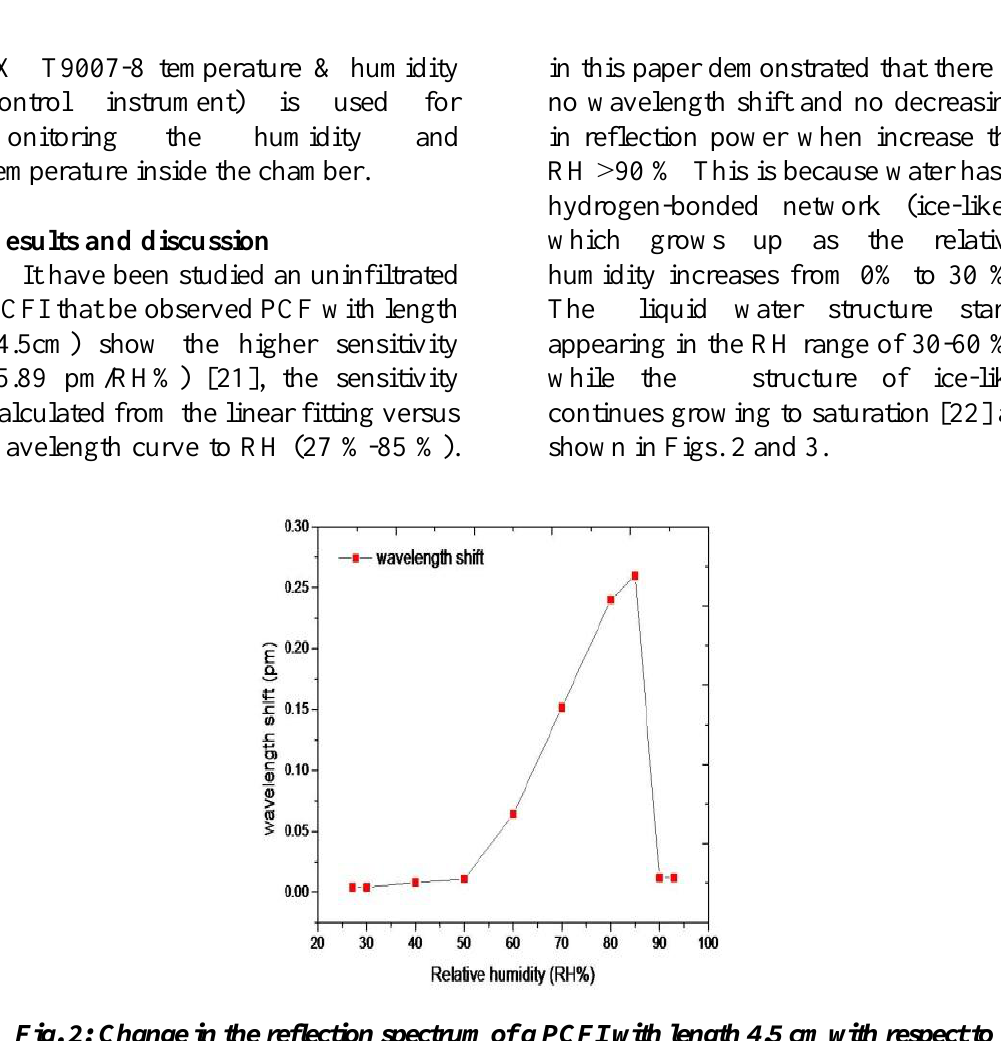
Fig. 2: Change in the reflection spectrum of a PCFI with length 4.5 cm with respect to different ambient relative humidity values .